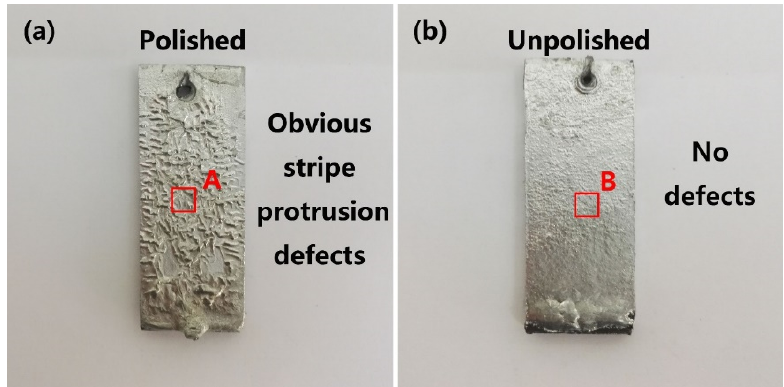
Figure 5. Macroscopic photos of coatings. ( a ) Polished steel plate, ( b ) Unpolished steel plate.